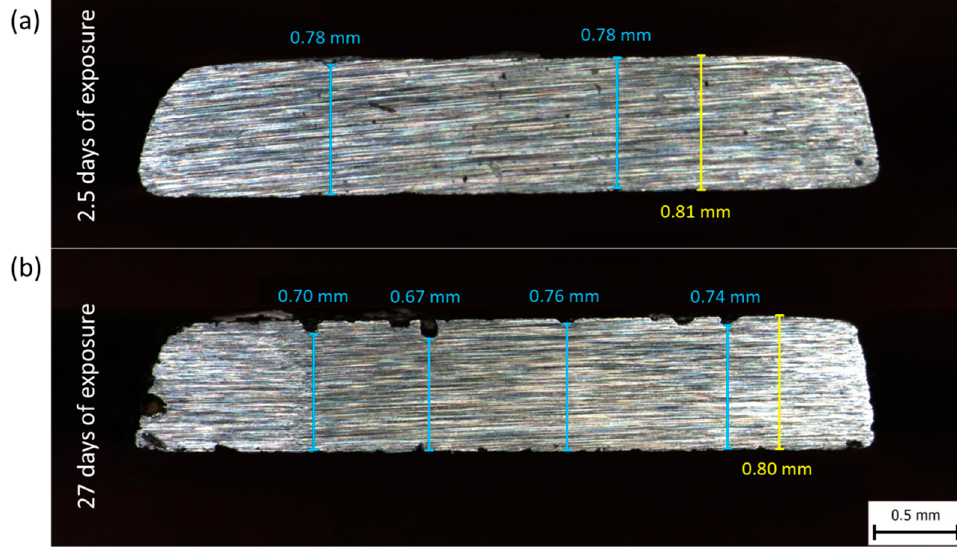
Figure 8. Photographs of cross section of the Corroding SSRT specimens with NaCl deposits and exposed in humid air at 85% RH for 2.5 days ( a ) and 27 days ( b ).